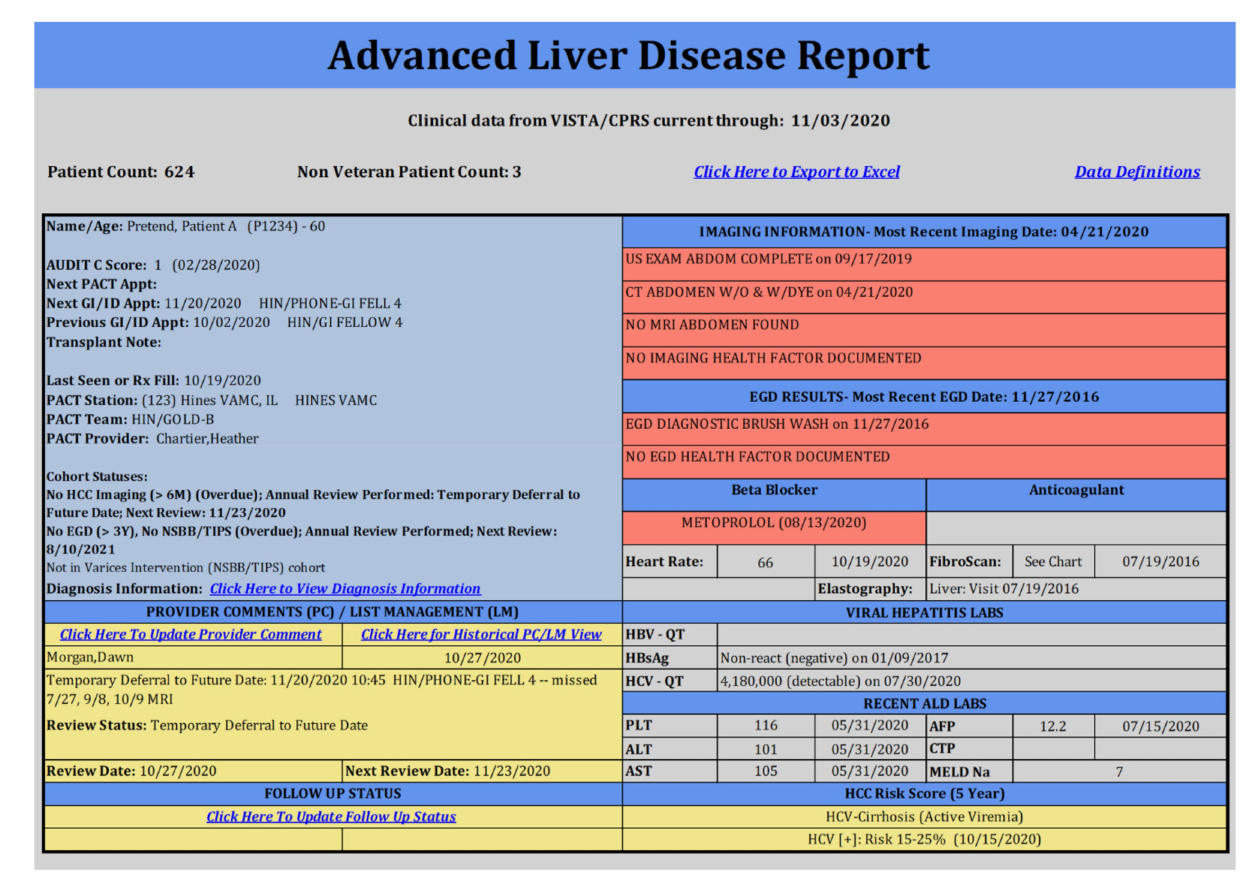
Figure 1. Mock Screenshot of Advanced Liver Disease